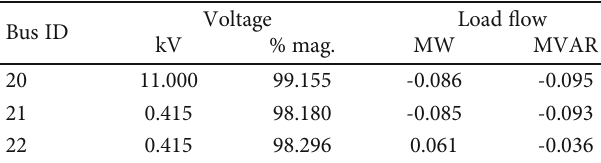
Table 7: Voltage pro fi le in Case 2. Table 8: Load Flow of N-M Network for Case 2.